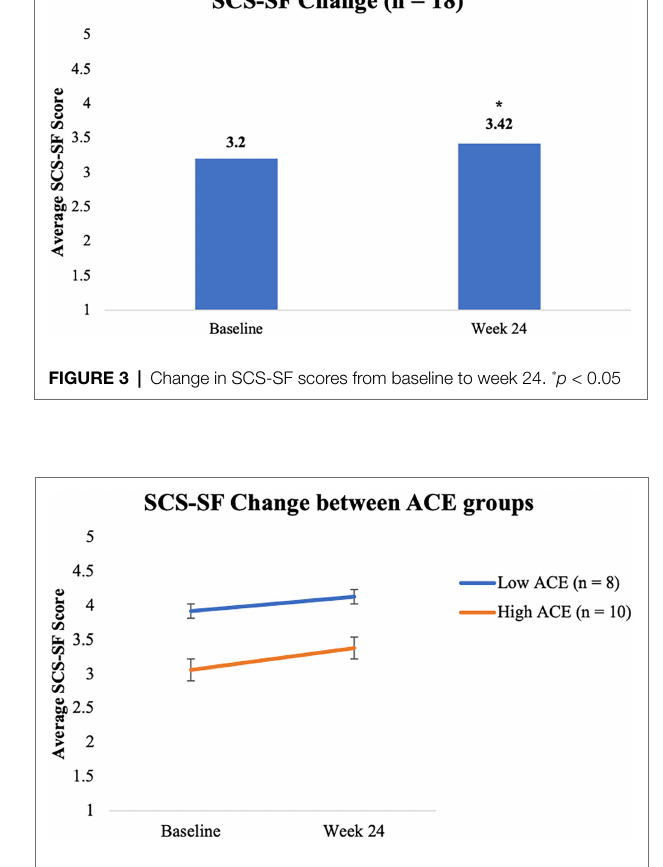
FIGURE 4 | Change in SCS-SF over time between ACEs groups.